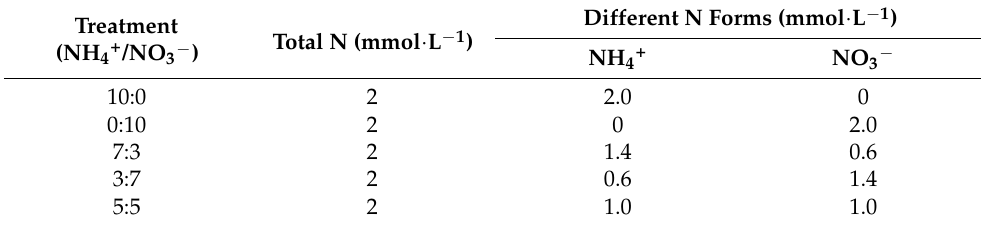
Table 1. Treatments with different nitrogen